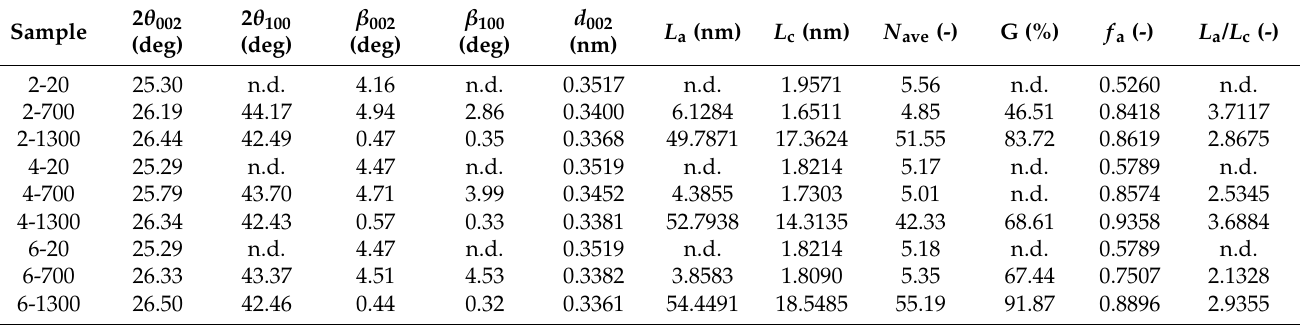
Table 2. Statistics of crystallite lattice